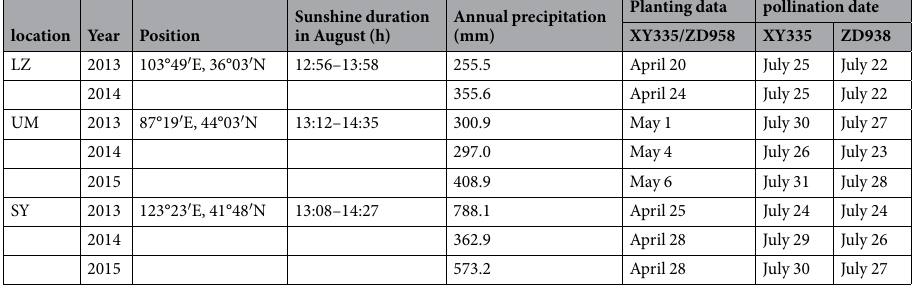
Table 1. Ecological conditions and plant growth statuses in Lanzhou (LZ), Urumqi (UM) and Shenyang (SY) over 2–3 years (2013, 2014 and